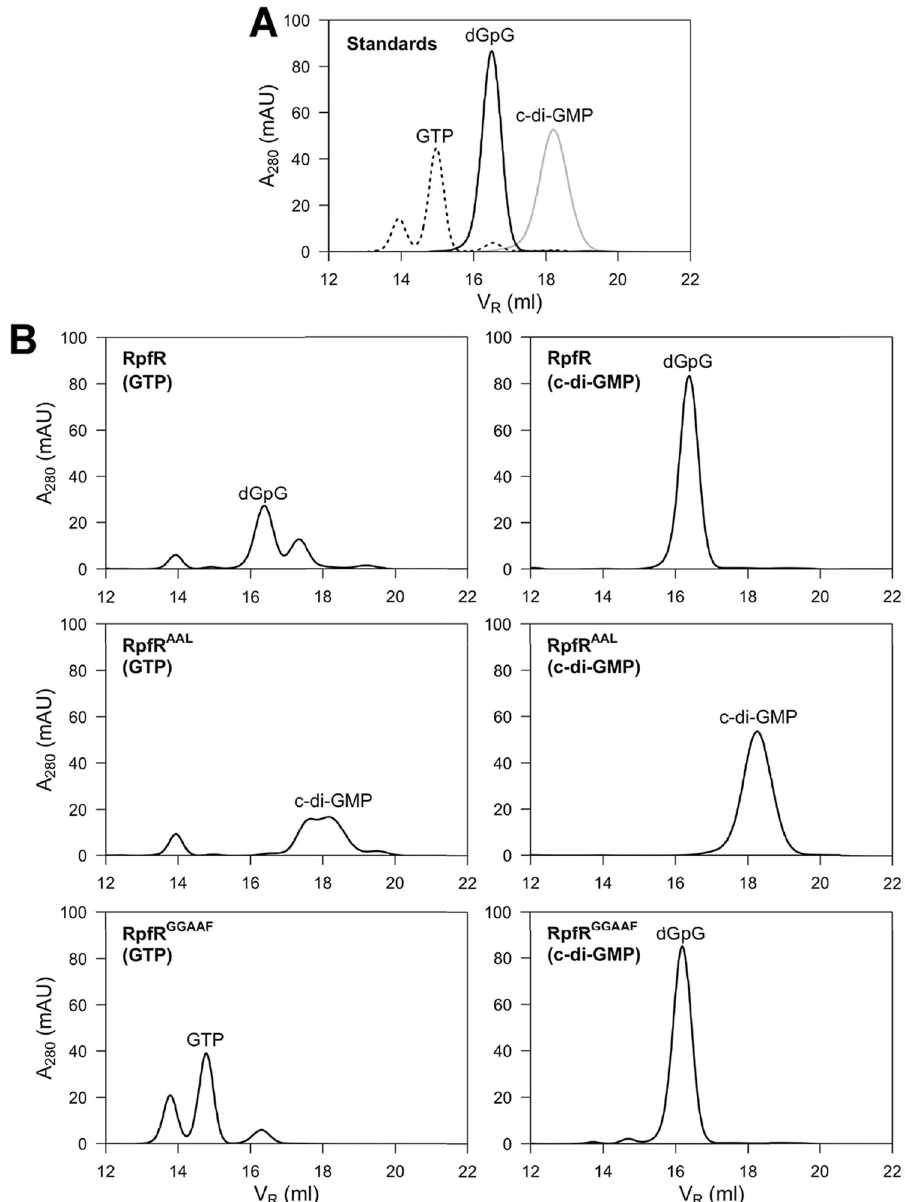
Fig. 7 In vitro DGC and PDE activity of RpfR variants. Puri fi ed proteins were incubated with GTP or c-di-GMP as substrate and reaction products were analyzed by FPLC. A Elution pro fi le of the indicated nucleotide standards. B Reaction products of RpfR variants incubated with GTP (left panel) or c-di-GMP (right